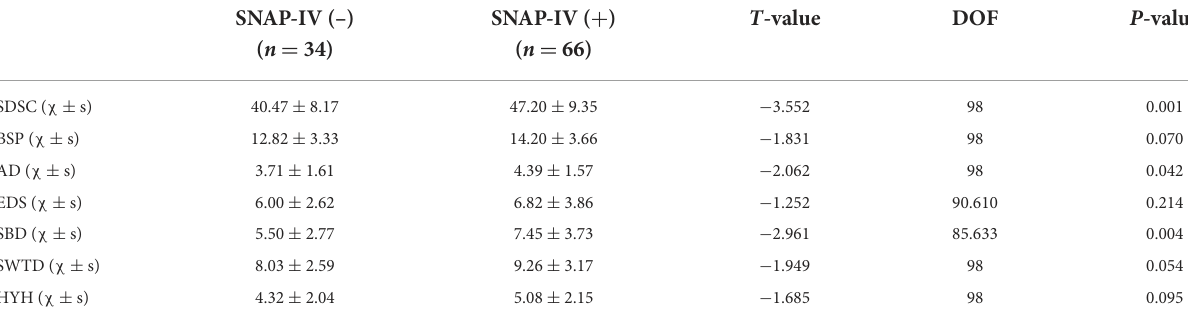
TABLE 2 Comparison of SDSC scores in children with and without